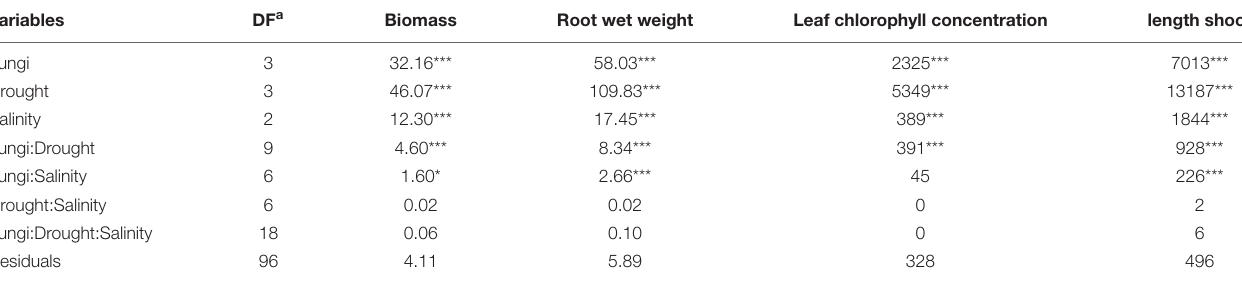
TABLE 1 | Three-way analysis of variance (ANOVA) of the effects of the halotolerant fungal endophytes, P. macropinosa , N. goegapense , and N. chichastianum on the growth parameters and leaf chlorophyll concentration of Hordeum vulgare L. (barley) under different levels of salinity and drought stresses. Variables DF a Biomass Root wet